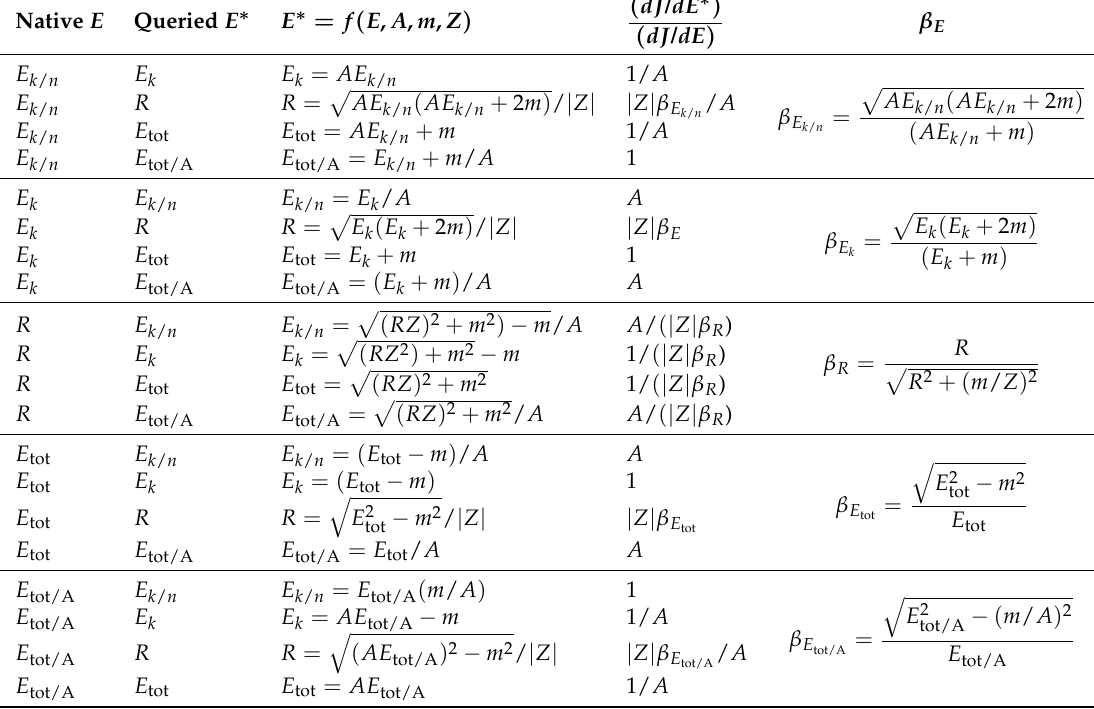
Table A1. Conversion between CRDB energy axes. The columns are (i) the native energy axis ( E ) , (ii) the queried axis E ∗ to which to convert, (iii) the relation between E ∗ and E , (iv) the relation between the converted flux dJ / dE ∗ and the native flux dJ / dE , and (v) β = v / c expressed as a function of the native energy axis E . In the formulae below, m is the CR mass in GeV, and energies are in GeV ( E k and E tot ), GeV/n ( E k / n ), GV ( R ), or GeV/A ( E tot/A ). Native